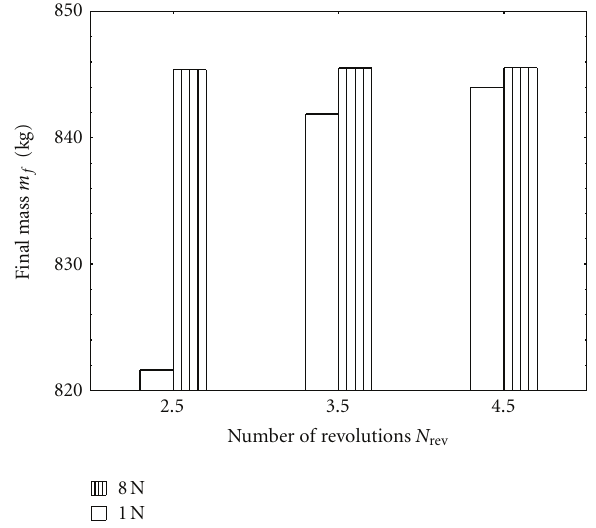
Figure 3: Final mass for di ff erent numbers of revolutions (J2